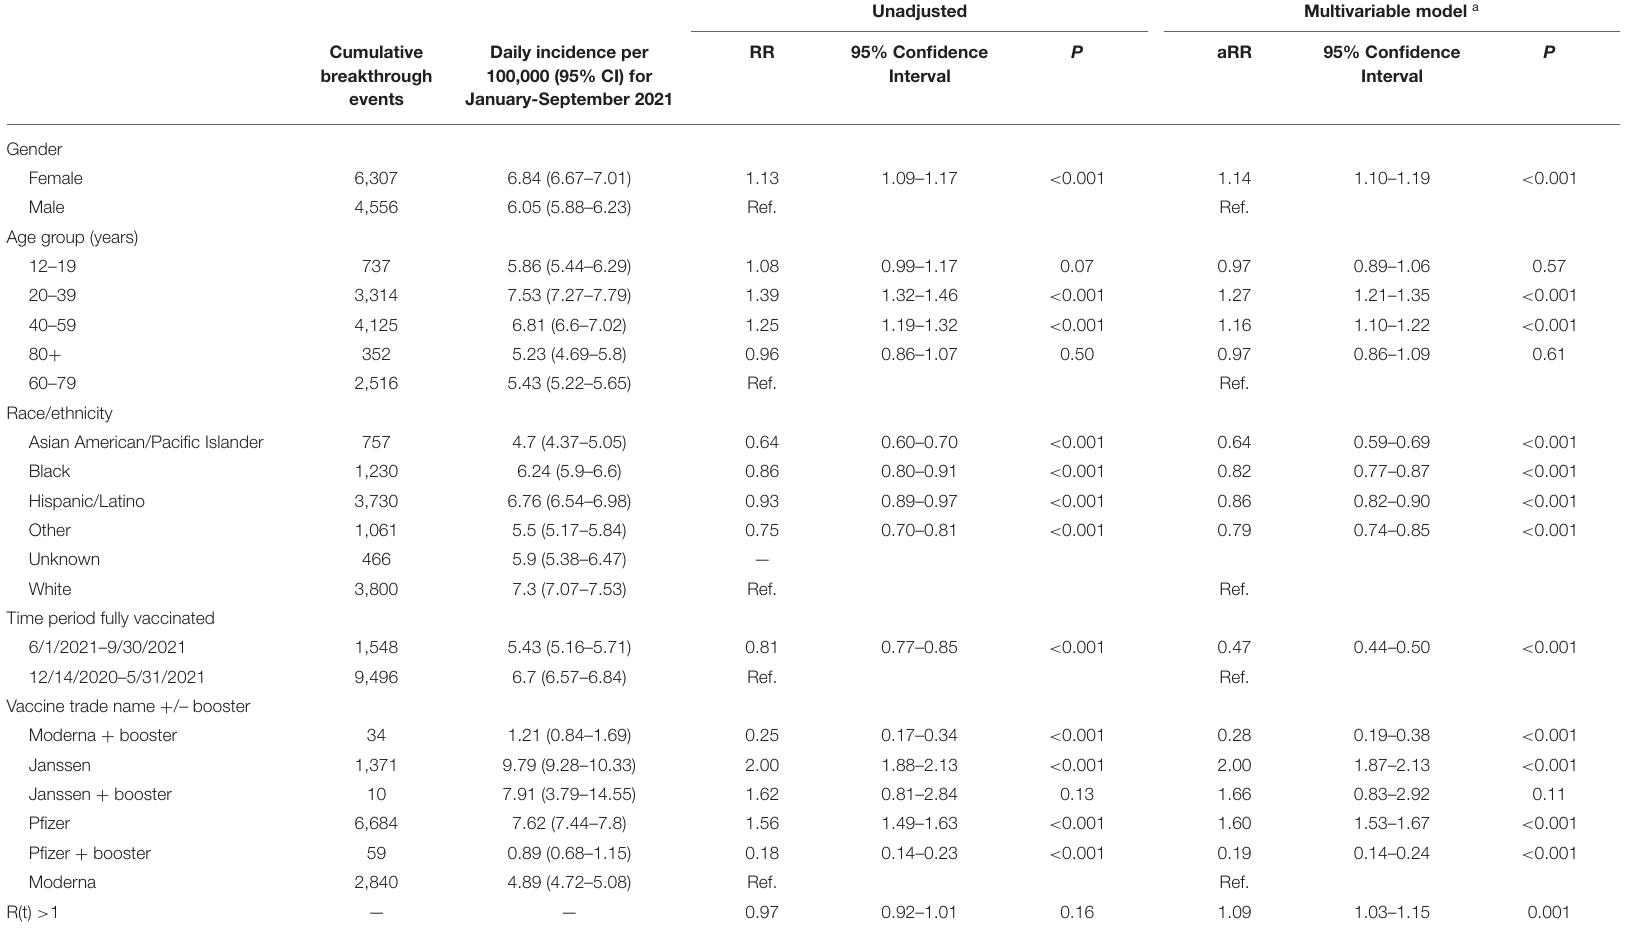
a Multivariable models are adjusted for all other variables in the